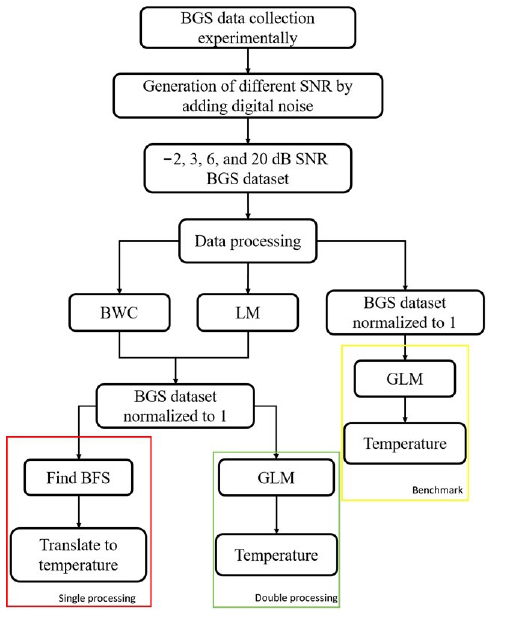
Figure 6. Data processing